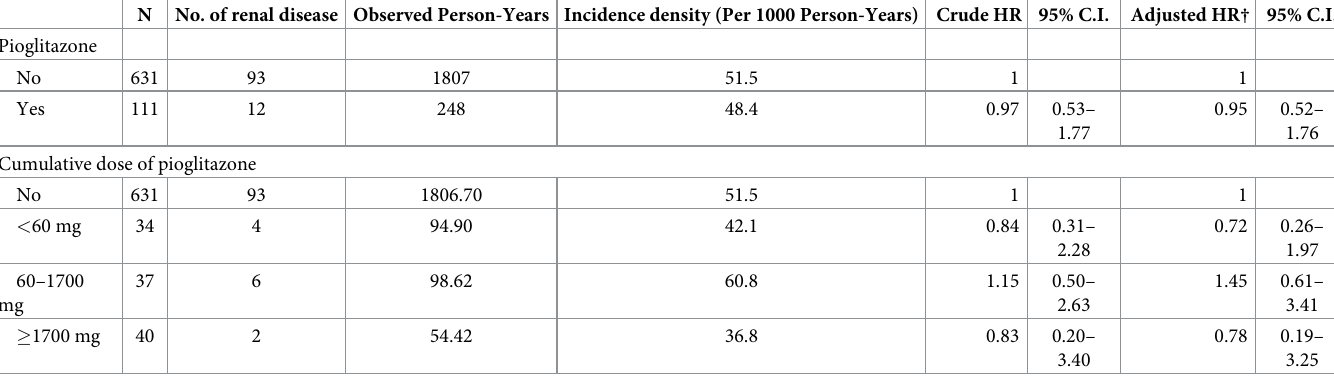
Table 2. The occurrence of primary renal endpoint between Pioglitazone and non- Pioglitazone